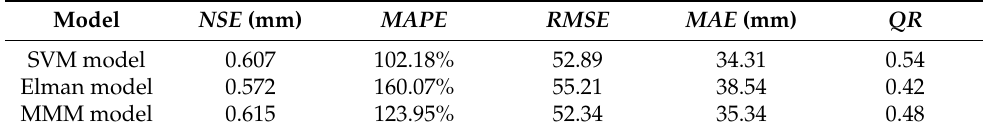
Table 2. Evaluation of model performance results through five